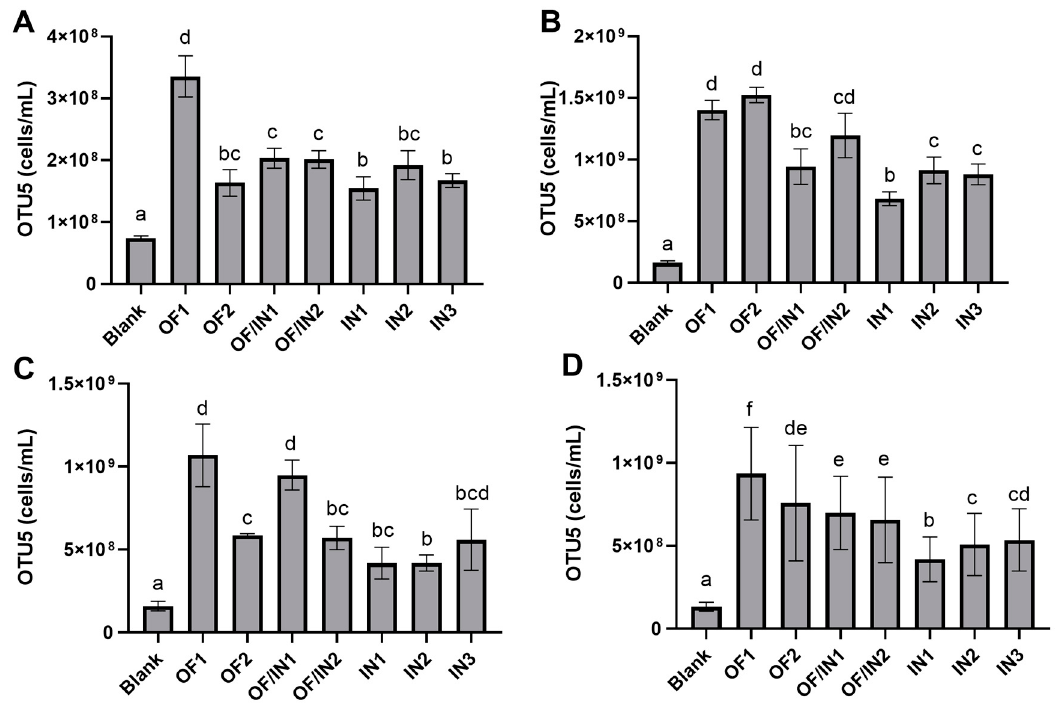
Figure 4. Selective growth of OTU5 (related to Bifidobacterium animalis and upon data analysis reflecting the levels of BB-12) in presence of a complex microbiota upon dosing BB-12 and fructans with short (OF1, OF2), intermediate (OF/IN1, OF/IN2) and high degree of polymerization (IN1, IN2 and IN3) versus a blank incubation. Bars represent the average absolute levels (cells/mL) of OTU5 after 48 h of colonic incubation for donors C ( A ), D ( B ) and F ( C ) together with the averages over the three donors ( D ) ( n = 3 for each donor). Results are expressed as average ± SD for the individual donors and average ± SEM for the average over the donors. Conditions that have no letter in common are statistically significantly different from one another ( p < 0.05). OTU = operational taxonomic unit; BB-12 = Bifidobacterium animalis subsp. lactis; OF = oligofructose; IN = inulin; SD = standard deviation; SEM = standard error of